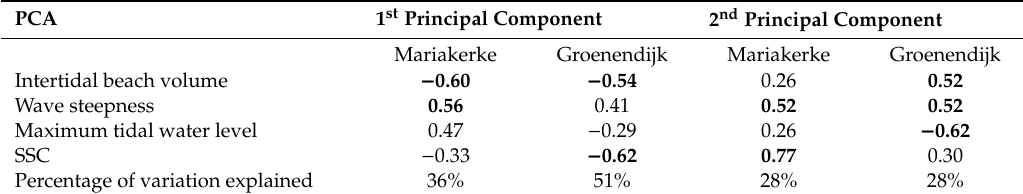
Table 5. Correlations between daily intertidal beach volume change, daily averaged wave steepness, maximum water level, daily averaged SSC, and the first two principal components for Mariakerke and Groenendijk. High correlations are in bold ( > 0.5).